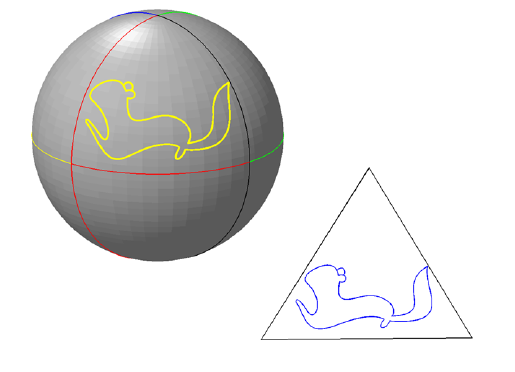
Figure 27. The shape of the squirrel is composed of 10 parametric curves (equations). In the planar triangle, there is the planar version of the curves that use the same form of expressions as the spherical version.